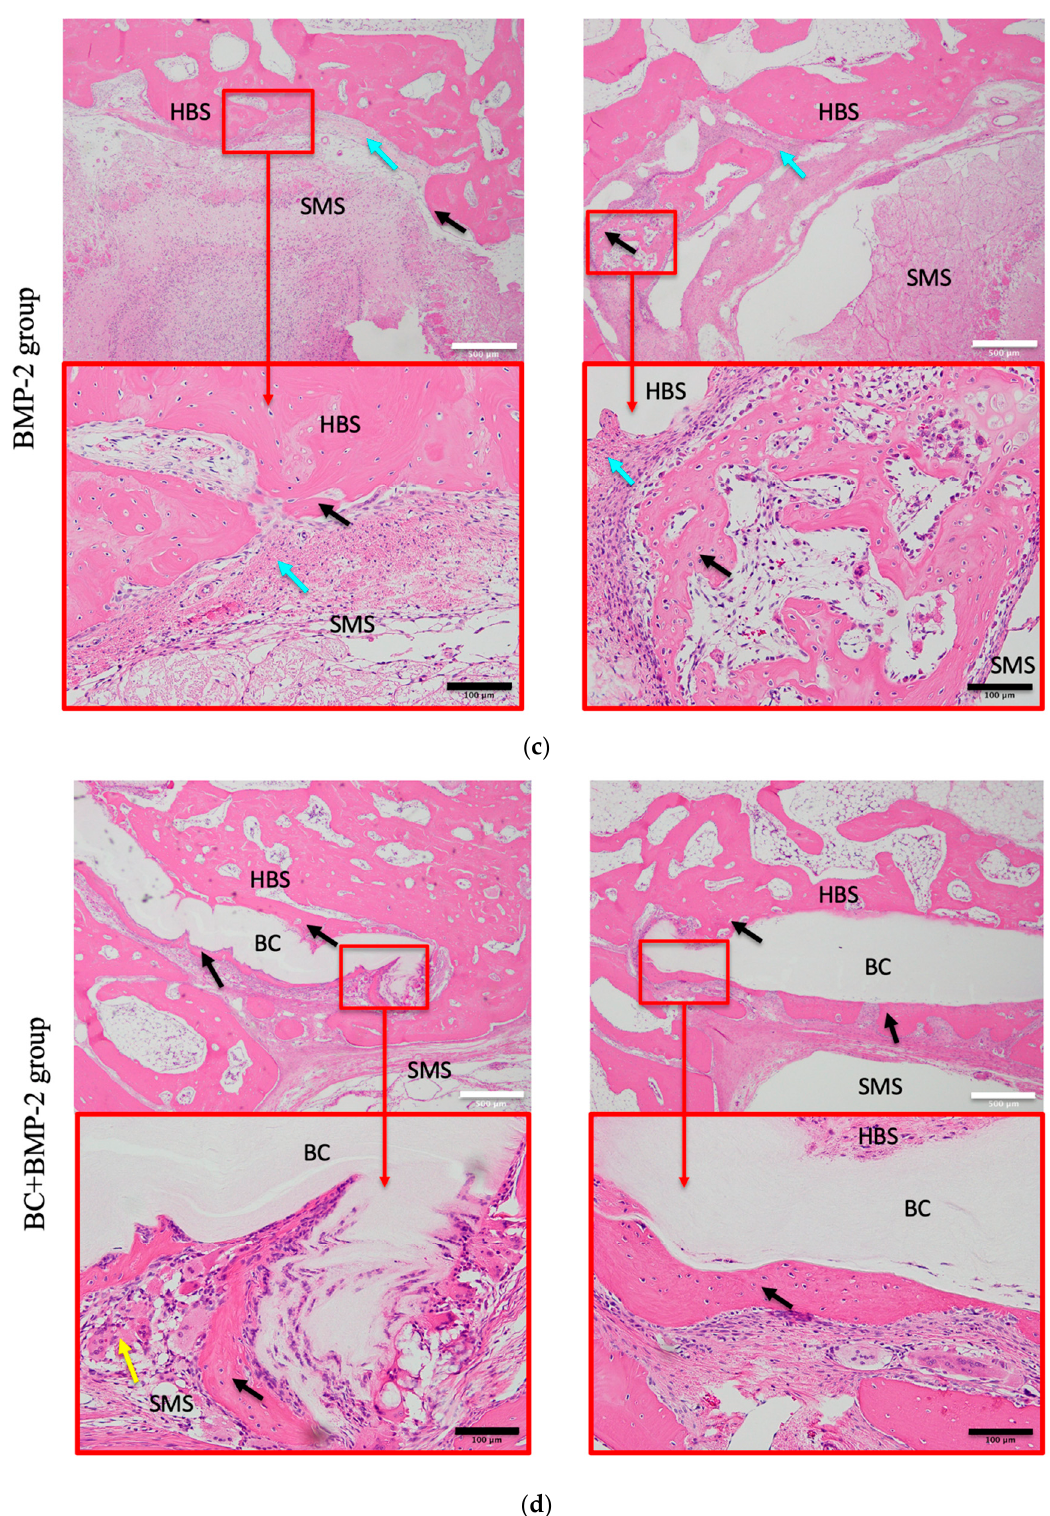
Figure 3. H&E staining in the ( a ): sham (n = 3), ( b ): BC (n = 3), ( c ): BMP-2 (n = 3), and ( d ): BC + BMP-2 (n = 3) groups at four and eight weeks. Blue arrows indicate connective tissue, black arrows indicate newly formed bone, and yellow arrows indicate cartilage tissue. HBS, host bone side; SMS, sinus membrane side; BC, bacterial cellulose. White scale bars (500 µ m) indicate slices at 4 × magnification; black scale bars (100 µ m) indicate slices at 20 × magnification.